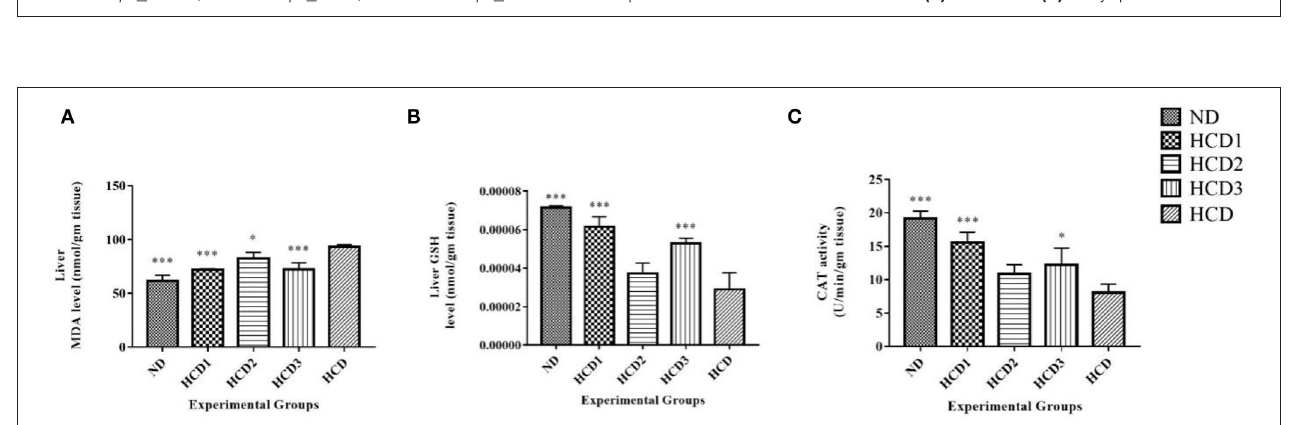
FIGURE 8 | Liver and organ lipid indexes in different experimental rat groups. Analysis was done by One-way ANOVA followed by Dunnett’s post-hoc test where ***indicates p ≤ 0.001, **indicates p ≤ 0.01, and *indicates p ≤ 0.05. All data represented as mean ± SD of 6 animals. (A) Liver index. (B) Body lipid index.